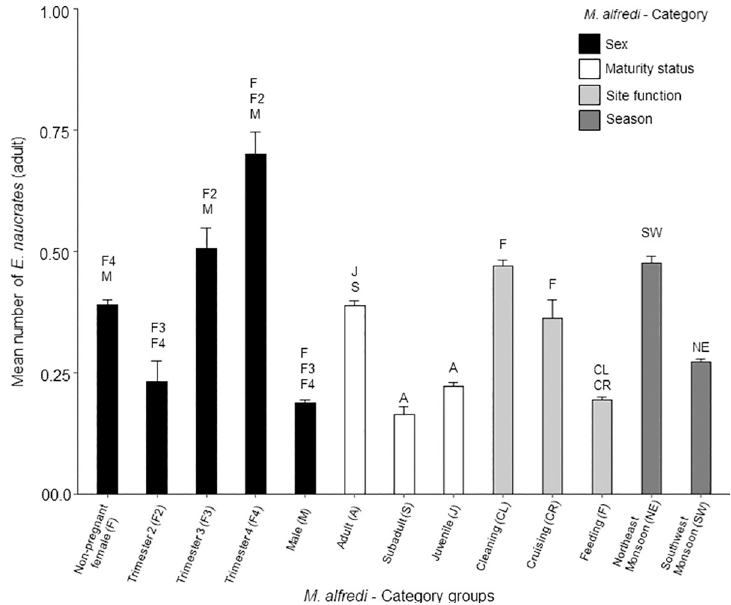
Fig 4. Daily mean number of adult Echeneis naucrates (+SE) observed with Mobula alfredi between category groups. Each category is coloured as per legend with group name below each bar. Letters above each bar correspond to those in brackets after the group name and indicate the groups with a significant difference ( p <